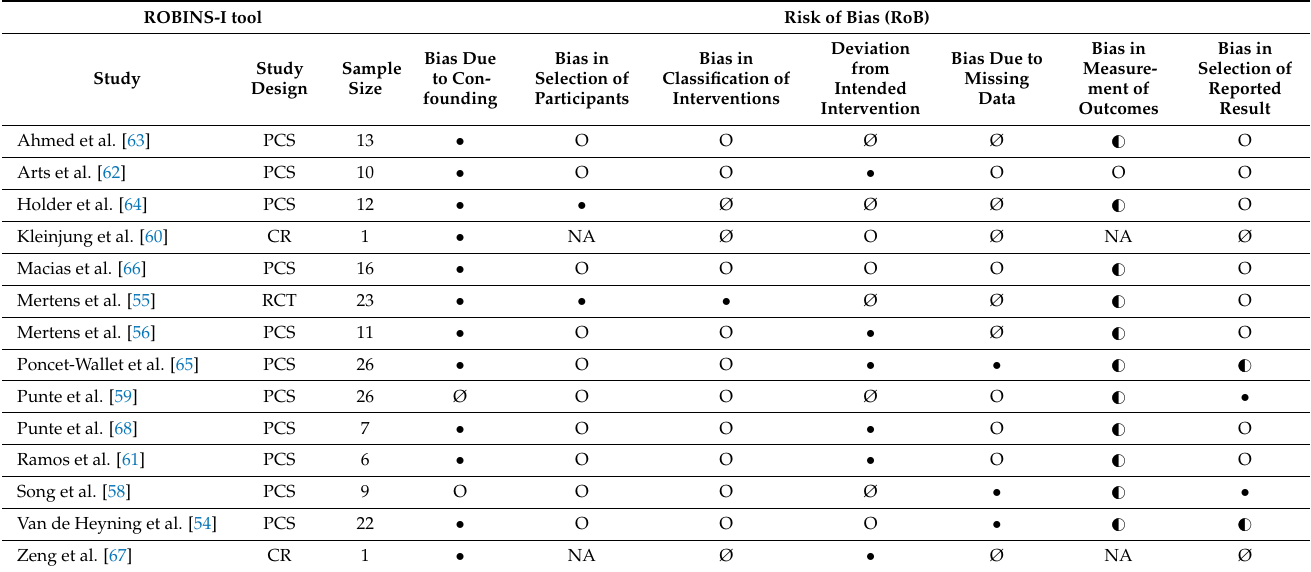
Table 1. Quality assessment of studies in which tinnitus was the primary